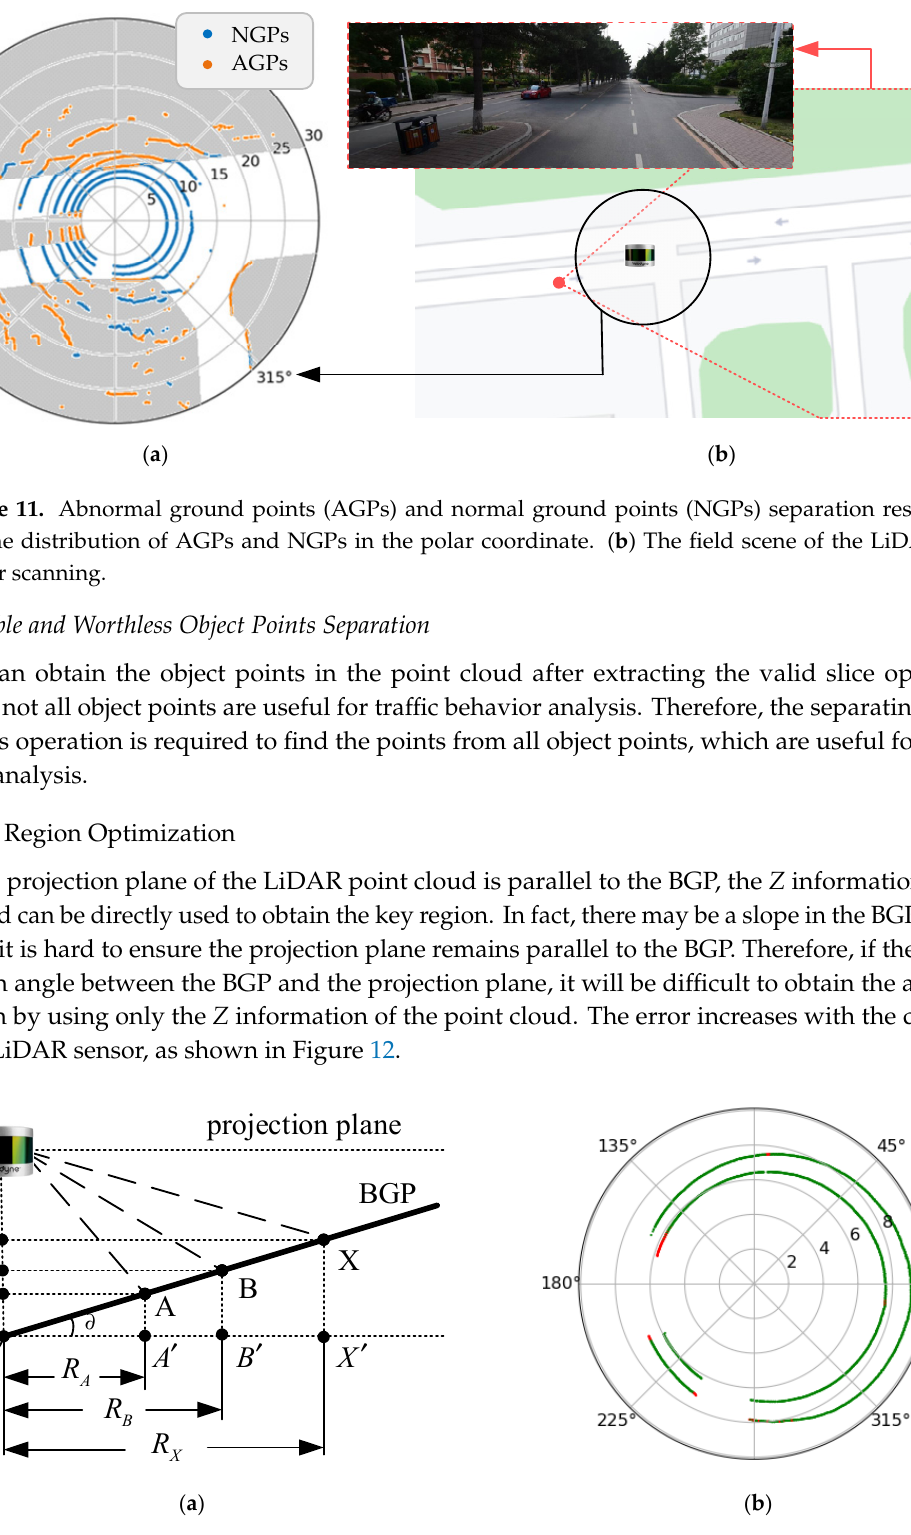
Figure 12. Calculating the slope between the base ground plane (BGP) and the projection plane. ( a ) A mathematical model using LiDAR to calculate the slope; ( b ) The points used to calculate the slope.